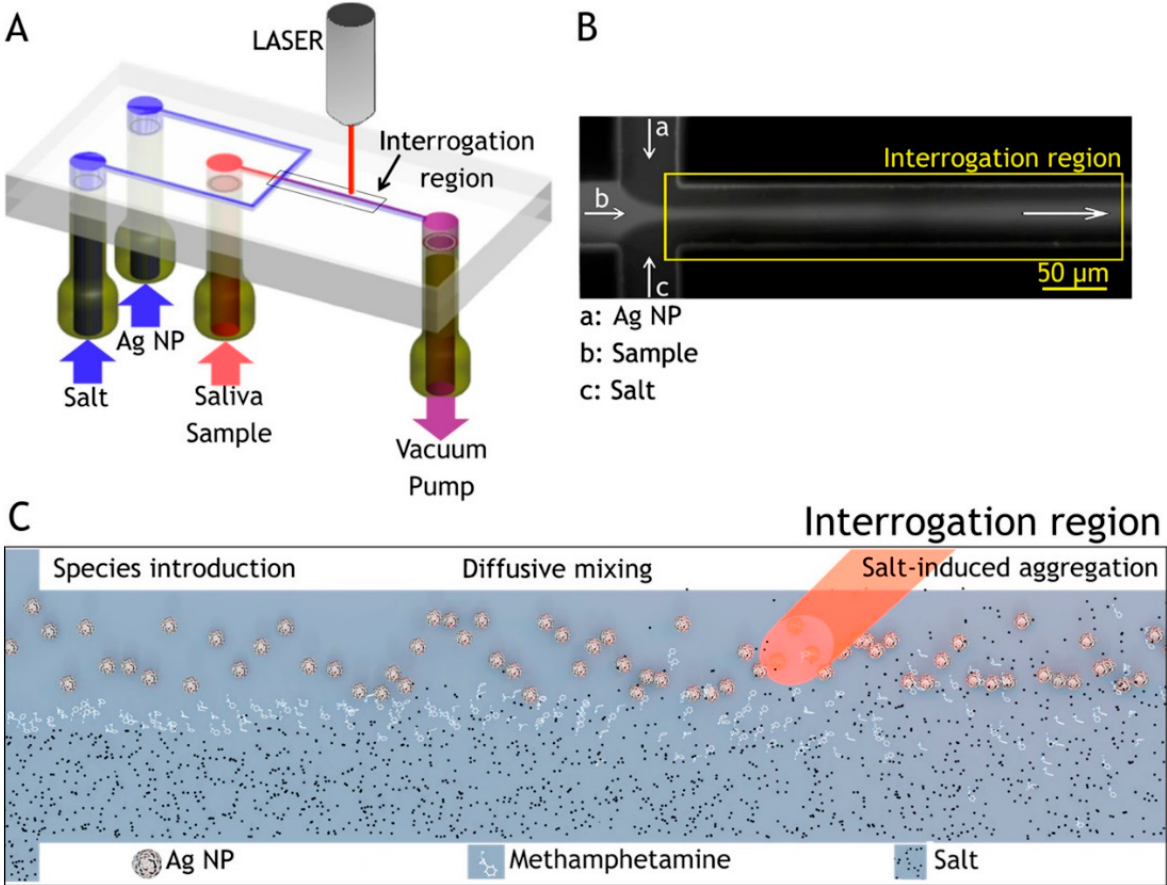
Figure 5. Flow-focusing microfluidic device used for controlled Ag-NP aggregation [105]. ( A ) Ag-NP suspension, a saliva sample, and salt solution are loaded in the device and driven through it by a vacuum pump. ( B ) At the flow-focusing junction, the sample stream is enveloped by the side- streams and diffusion drives lateral mass transport between the laminar flows, here visualized with a fluorescent dye. ( C ) Ag NP, analyte, and salt solution are introduced to the channel from the left and flow toward the right. Analyte molecules resident in the focused stream diffuse laterally into the side flows. Salt ions also diffuse into the colloid stream inducing controlled nanoparticle aggregation, creating SERS-active clusters that convect downstream [105].